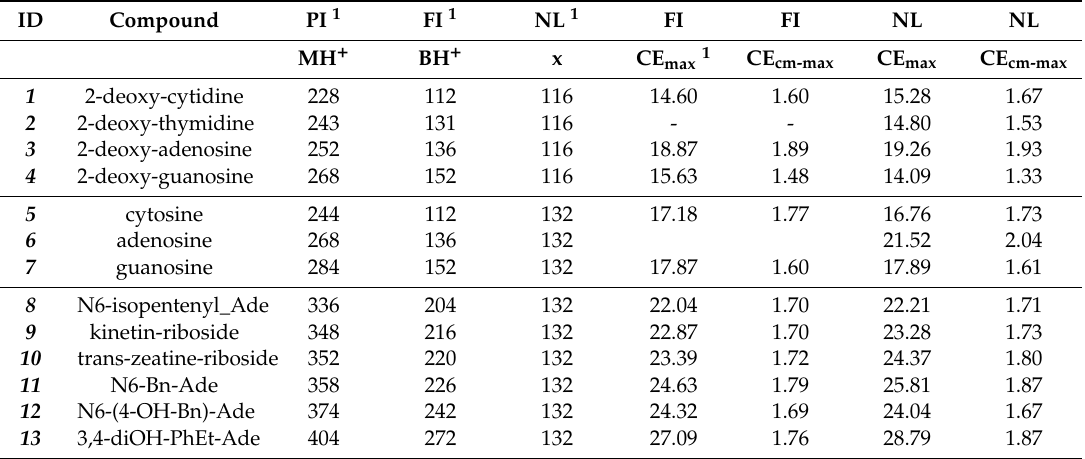
Table 2. Collection of CE max and corresponding CE cm-max measured for four DNA nucleosides, three RNA nucleosides and six modified adenine